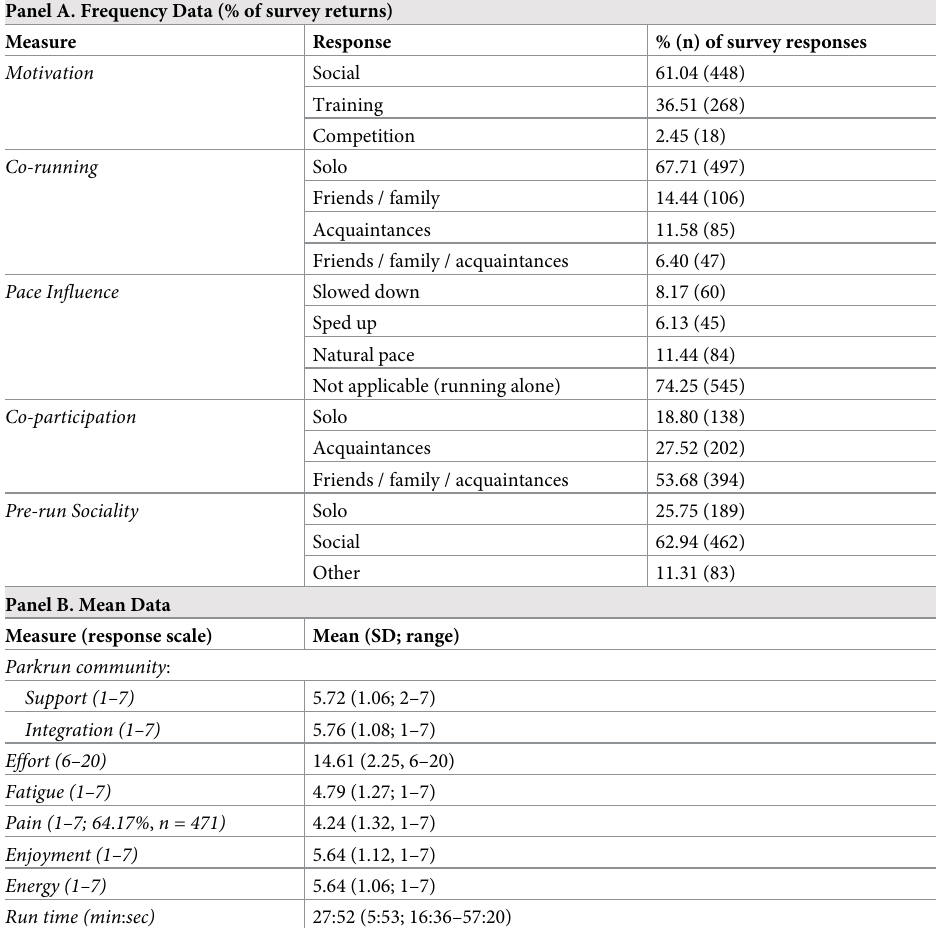
Table 2. Descriptive results for survey and run-time